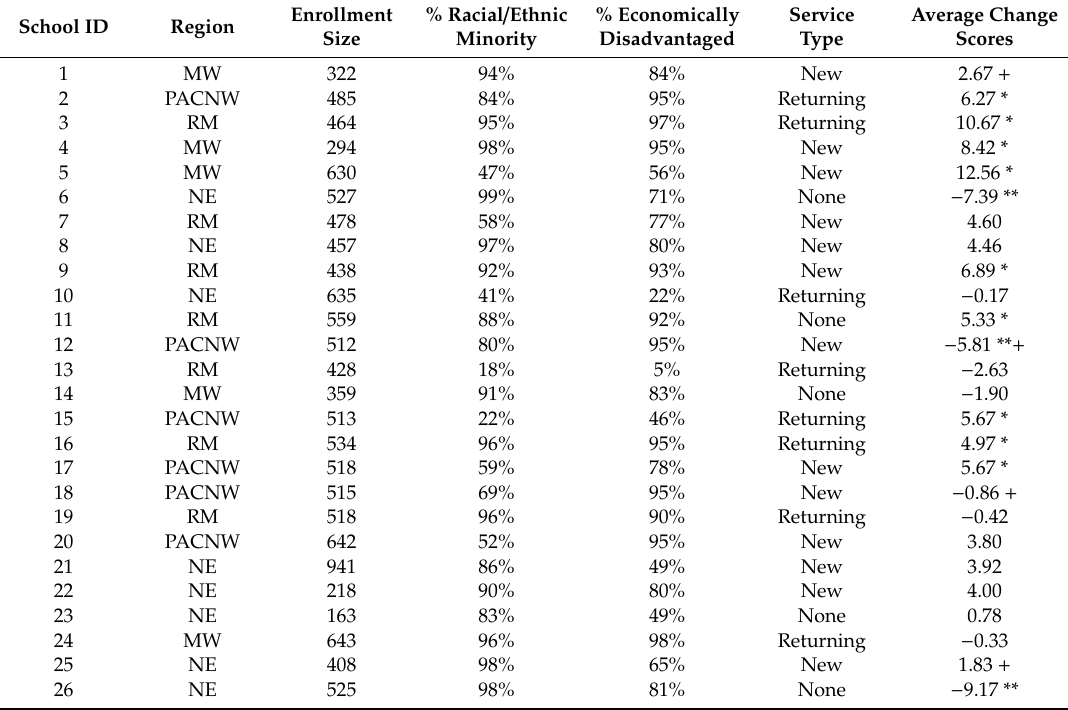
Table 1. Demographic Information and Average Change Scores of